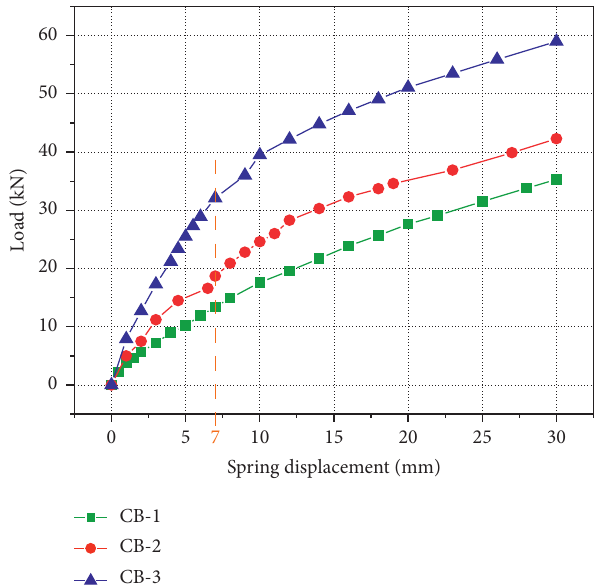
Figure 6: Load-spring displacement